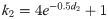
Comparison of effects between the cases of no tracking (r = 0) and tracking (positive r): cross–type structure.(A,B) dependence of mean expression and noise intensity on the green loop length for a fixed tracking ratio (r = 0.1), where the dashed lines correspond to the side-by-side loops; (C,D) dependence of mean expression and noise intensity on tracking ratio for a fixed green loop length; (E,F) three–dimensional pseudo diagrams for dependence of the mean expression level/the noise intensity on both the loop length and the tracking ratio, where the color change in the bar represents the change in the mean level or in the noise. Parameter values are set as d1 = 1500, μ = 10, δ = 1, r = 0.1, λ21 = λ32 = λ34 = λ41 = 0.3, k1 = 0.5, and k2=4e−0.5d2+1 with d2 ∈ (0,10000) in (A) and (B) but k2 = 0.5 in (C) and (D).